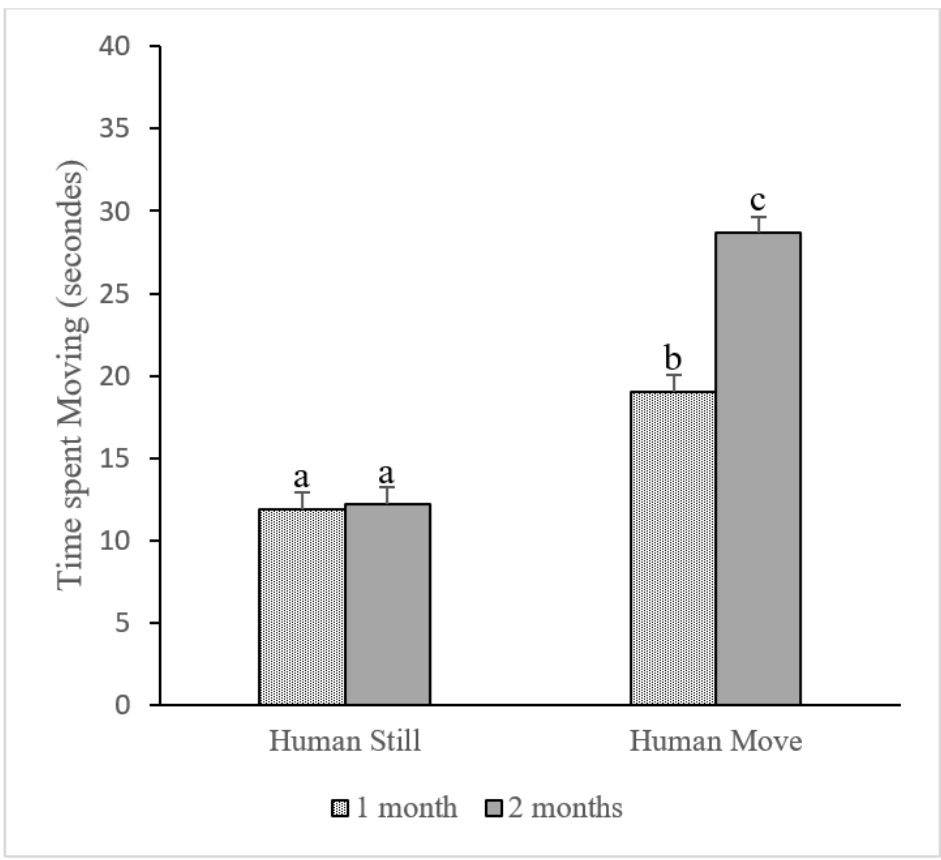
Figure 3. Time spent moving by the puppies. Puppies generally moved significantly more when the experimenter was walking compared to when she was still. The moving behavior of one- and two-month-old puppies did not differ when the experimenter was still (LME with permutation test, p > 0.05); however, it did significantly differ when she was moving (LME with permutation test, p = 0.000). Graphics represent means + standard errors (seconds). Different letters mean significant differences.